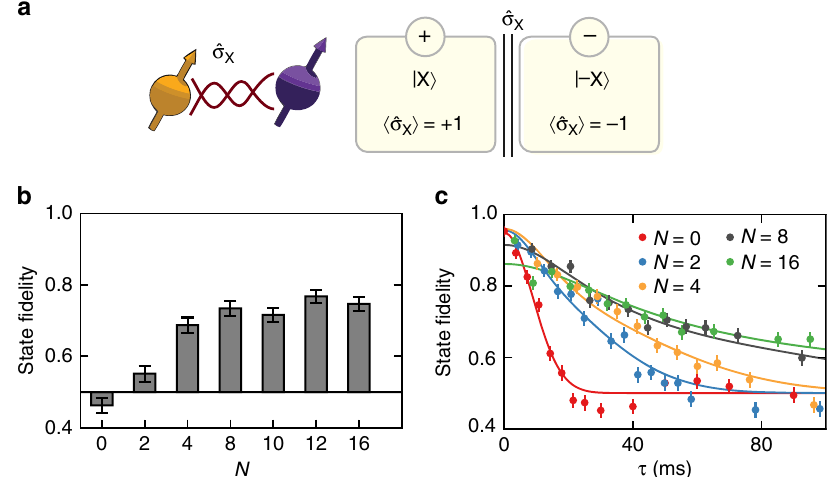
Figure 2 | Quantum Zeno effect for a single-spin superposition state. ( a ) Quantum Zeno subspaces for a single nuclear spin (spin 1) and ^ O ¼ ^ s x . Each eigenspace of ^ s x consists of one state (| X i or | (cid:2) X i ) with the respective eigenvalue indicated by the circled þ / (cid:2) signs. ( b ) State fidelity for | X i after t ¼ 40ms. The fidelity initially increases with the number of projections N . ( c ) The complete time traces for the storage of | X i show that the dephasing time increases with the number of projections. The curves are fits to the theoretically expected fidelity (see equation (3)). All data are corrected for the final read-out fidelity (Supplementary Fig. 4 and Supplementary Note 3). All error bars are 1